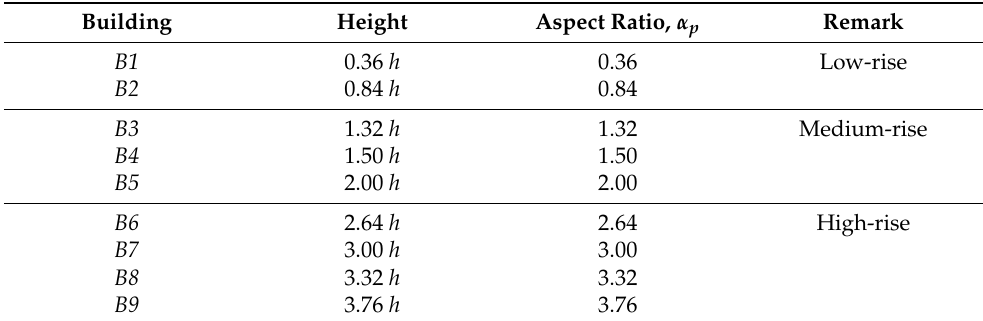
Table 2. Height of building blocks where h = 0.025